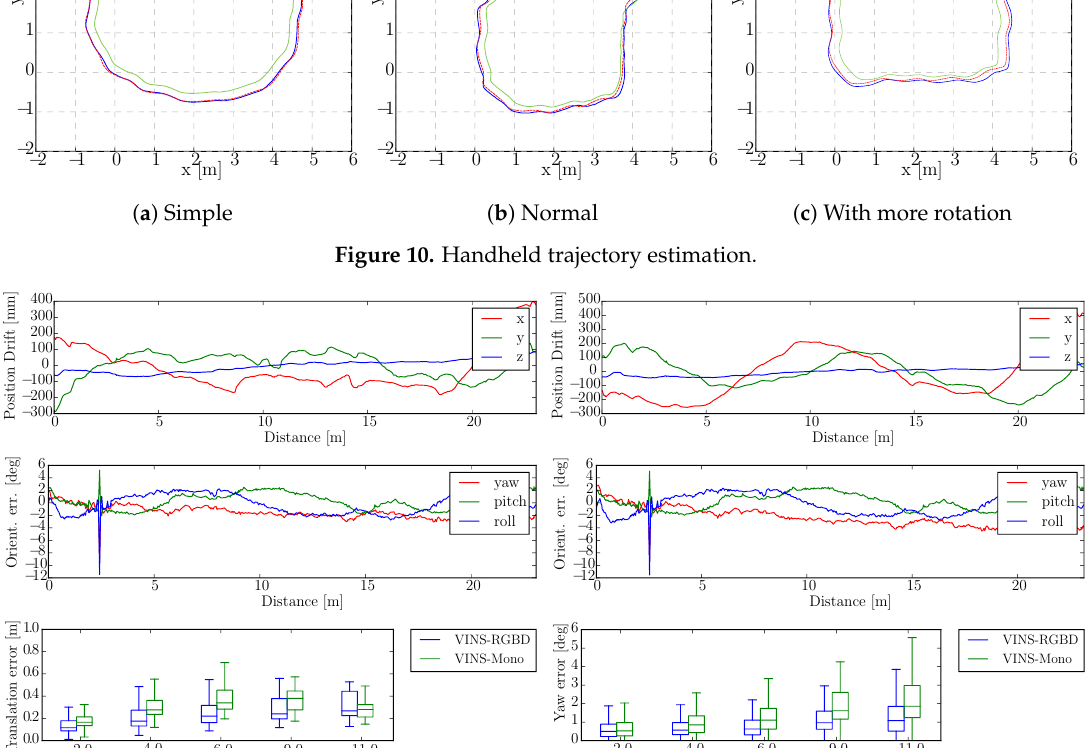
Figure 11. Handheld Absolute and Relative Error in “With more rotation” Experiment. The first two rows show the absolute position and orientation error, where the left results are from our VINS-RGBD and right are from VINS-Mono. The last row shows the relative translation and yaw error of our VINS-RGBD and VINS-Mono,